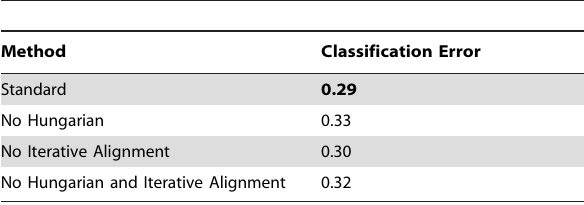
Table 6. CE for the Kahraman (5.3 A˚) data set from alternate versions using TI + Gyr to measure